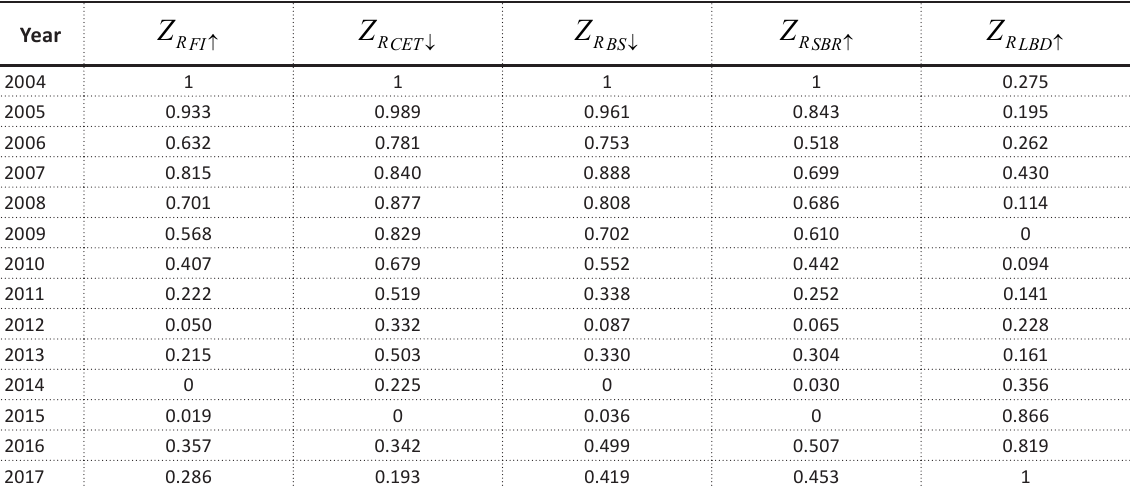
Source: Authors’ calculations.